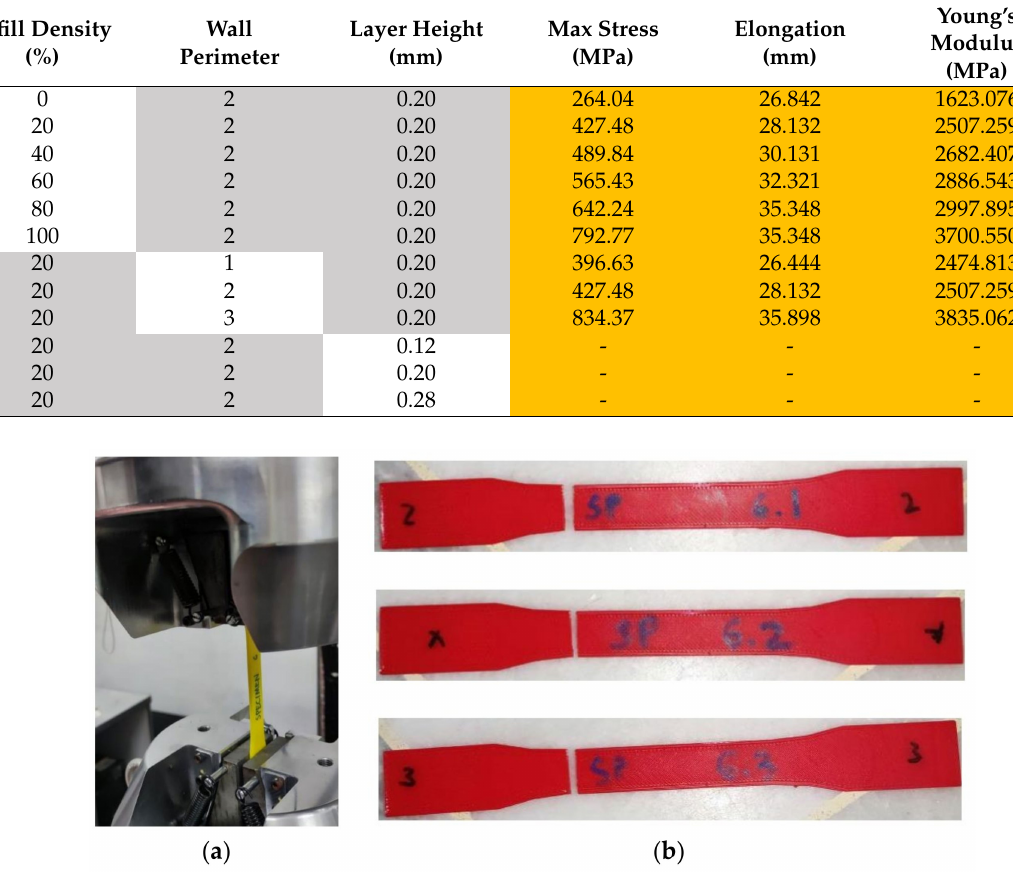
Figure 7. ( a ) Specimen set up in the universal testing machine and ( b ) sample of specimen 6 after testing. The data from the experimental analysis were calculated and are tabulated in Table 4. Table 4. Results for the experimental